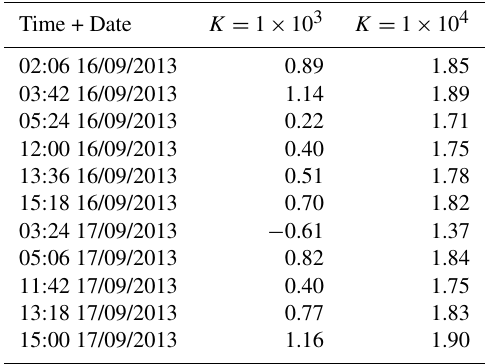
Table 4. Calculated fractional bias between VIIRS-retrieved total column mass loadings and modelled total column mass loadings where the emission rate in NAME is calibrated using the scaling coefficient ( K ) derived from a peak-to-peak scaling to the VIIRS